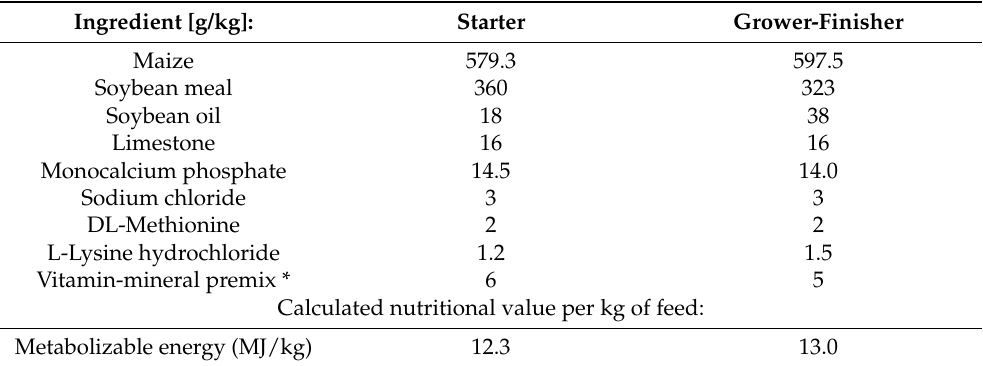
Table 1. Composition of experimental diets for starter (1–21 d) and grower-finisher (22–42 d) feeding phases and nutrient content in basal feed